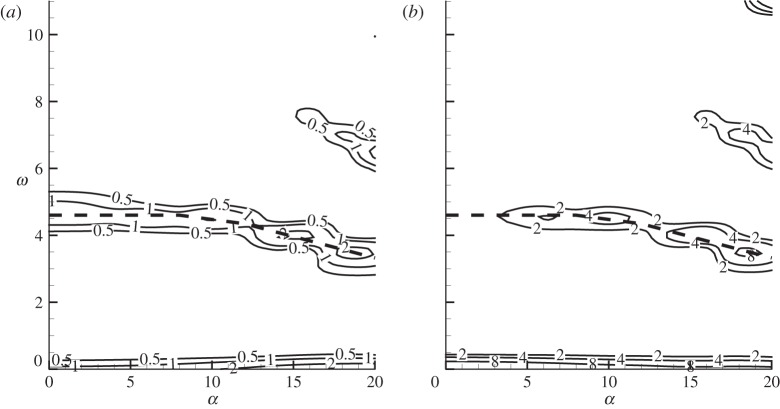
Contours of the b-norm of the sensitivity of (a) drag and (b) lift forces with respect to normal control at Re=1000. The thick dashed lines denote the dominant frequency of the uncontrolled forces.